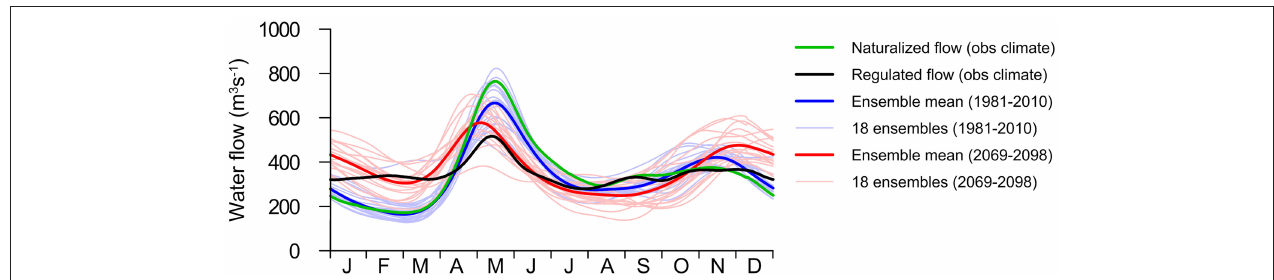
FIGURE 6 | Impact on river flow at Näs by hydropower regulation and climate change, respectively. Regulated flow is observed river flow, while naturalized flow is modeled using the observed climate (green) and the climate model data of current climate (blue) and by the end of the century (red).